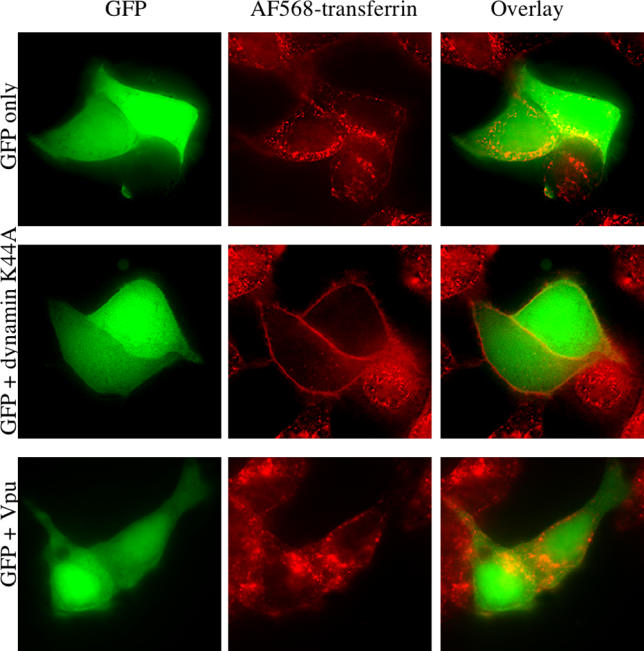
Vpu Expression Has No Effect on Transferrin EndocytosisHeLa cells were transfected with a control plasmid, or with plasmids expressing dynamin K44A, or Vpu together with a GFP-expression plasmid to mark transfected cells. Five hours after transfection, cells were transferred to serum-free medium. After overnight incubation, cells were then washed and incubated in fresh medium containing 5 μg/ml of transferrin conjugated to Alexa-Fluor-568. After 15 min of incubation, cells were fixed and images acquired.